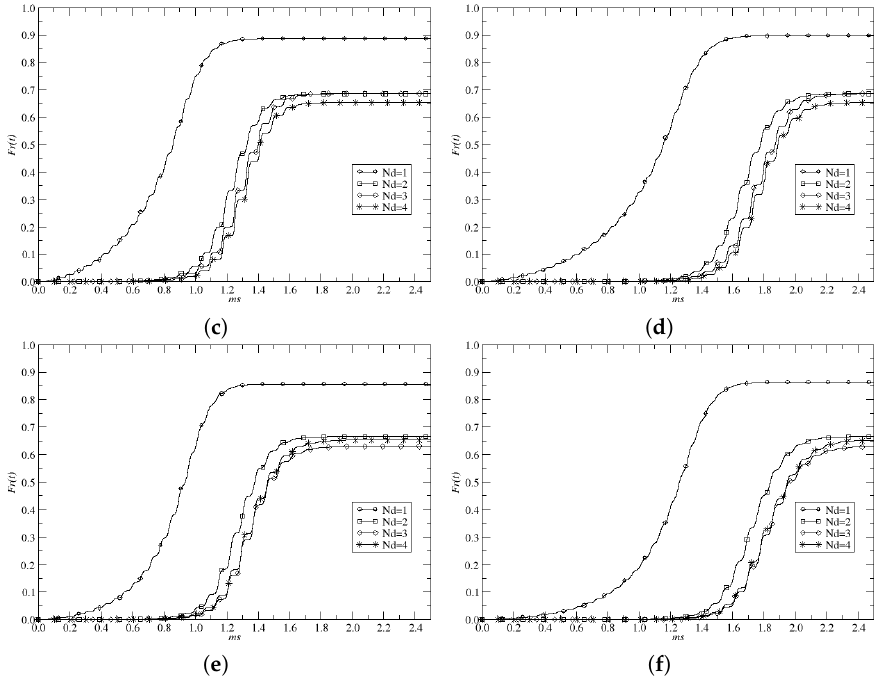
Figure 10. Service time of the secondary user using a queue size of 15 ( left column ) and 20 ( right column ) IUs. ( a ) Wl = 0.3, QS = 15. ( b ) Wl = 0.3, QS = 20. ( c ) Wl = 1.0, QS = 15.